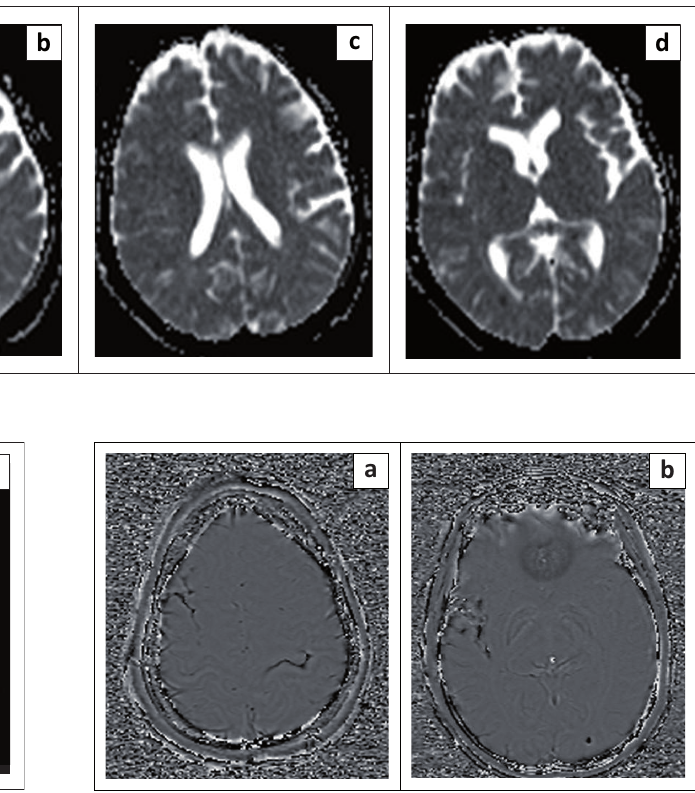
FIGURE 8: Corresponding axial PHASE MR images (a and b). FIGURE 7: Axial SWI MR images (a and